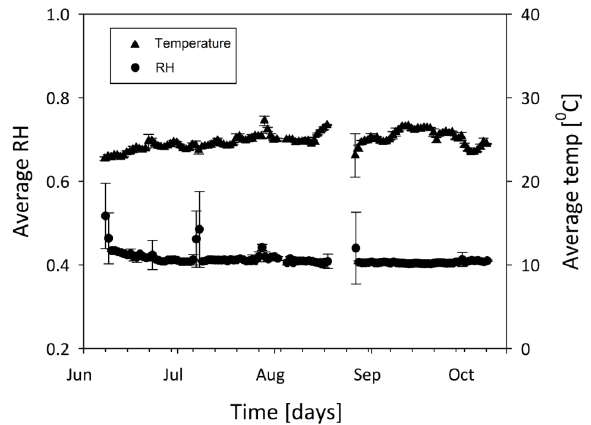
Figure A3. Measured temperature and relative humidity during the unsaturated column experiment. Each point is a daily average of 144 measurements and corresponding standard